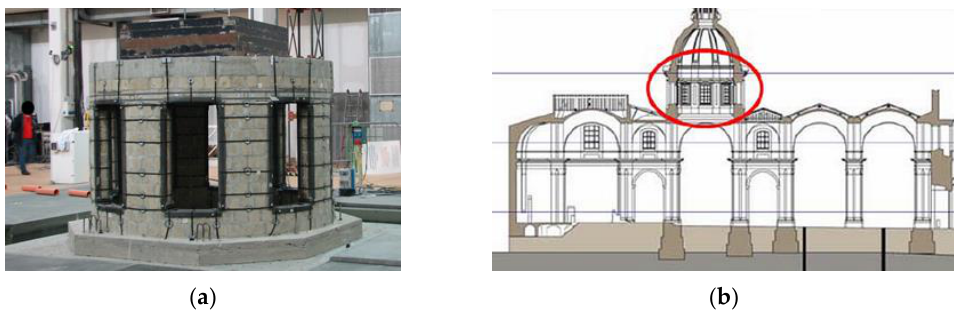
Figure 4. Church of San Nicolò l ’ Arena, Catania, Italy: ( a ) setup of shaking table test with strength- ening intervention on 1:5-scaled mockup of the drum; ( b ) position of the drum (red ellipse) in the structure.